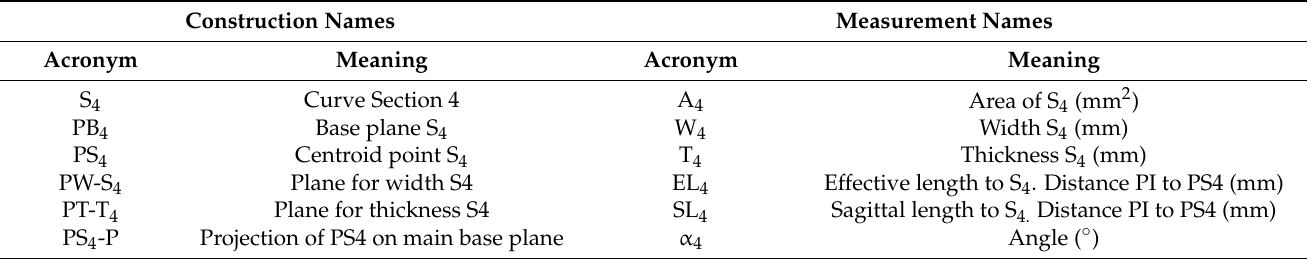
Table 1. Resume of recorded values and their respective acronyms. Example for Section 4 (S 4 ).